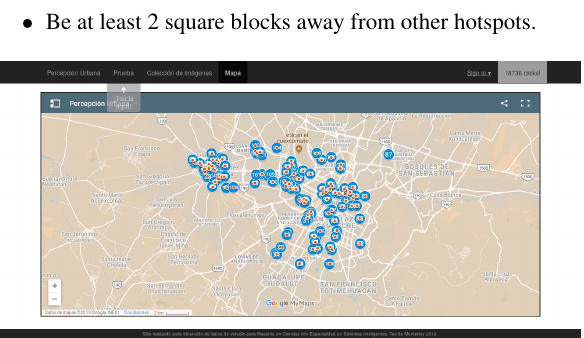
Figure 1. Hostpots location.